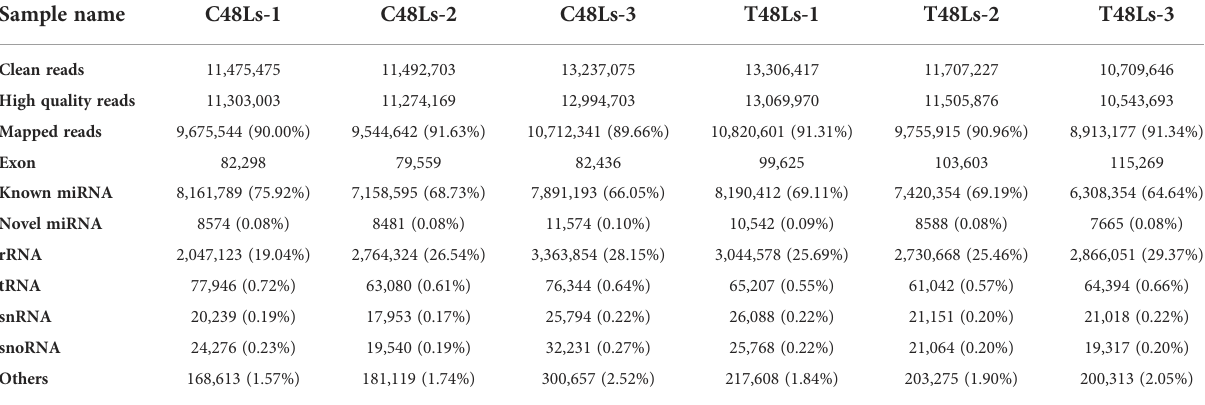
TABLE 2 Categorization of rainbow trout non-coding and organellar small